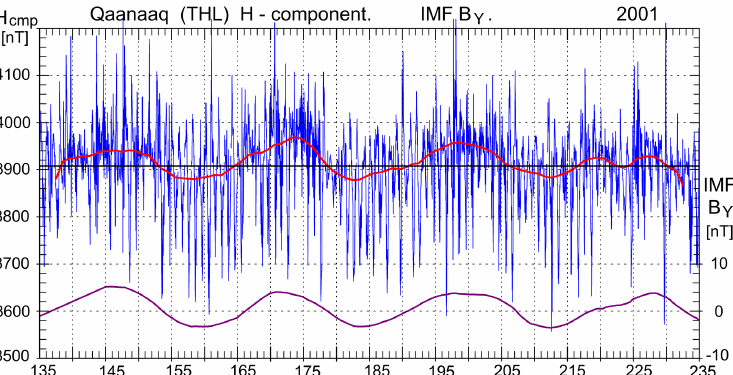
Figure 1. H -component data (20min avg.) from Qaanaaq for days 135–235 of year 2001 in the blue line. Smoothed H -component median values in the red line. Smoothed IMF B Y values in the magenta line on the right